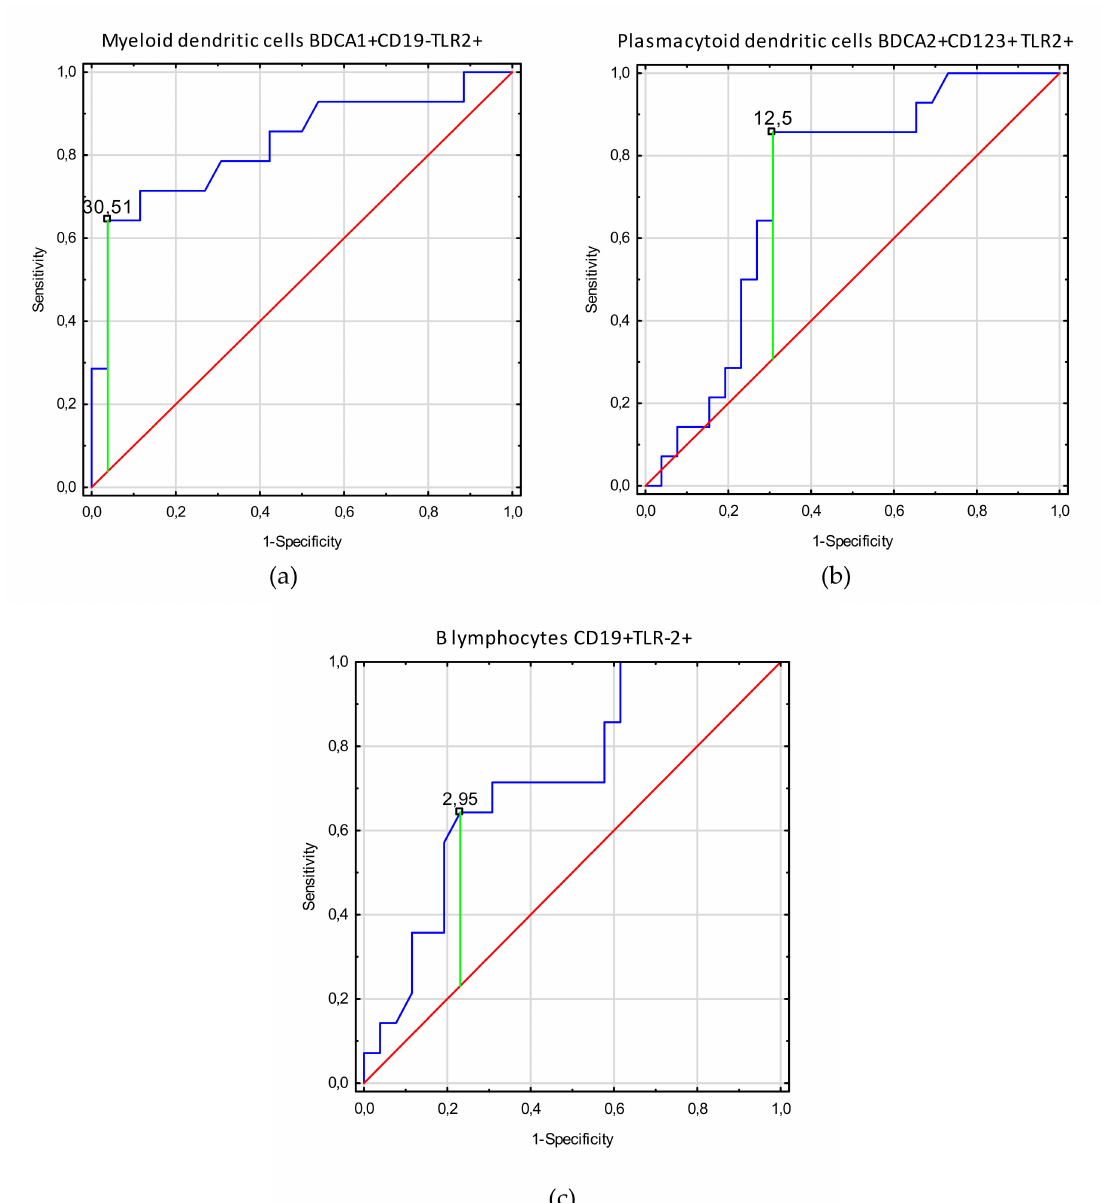
Figure 4. Receiver operating curve (ROC) analysis to determine diagnostic accuracy in di ff erentiation of endometriosis patients with and without infertility; ( a ) frequencies of myeloid dendritic cells BDCA1 + CD19-TLR2 + [%]; ( b ) frequencies of plasmacytoid dendritic cells BDCA2 + CD123 + TLR2 + [%]; ( c ) frequencies of B lymphocytes CD19 + TLR-2 +